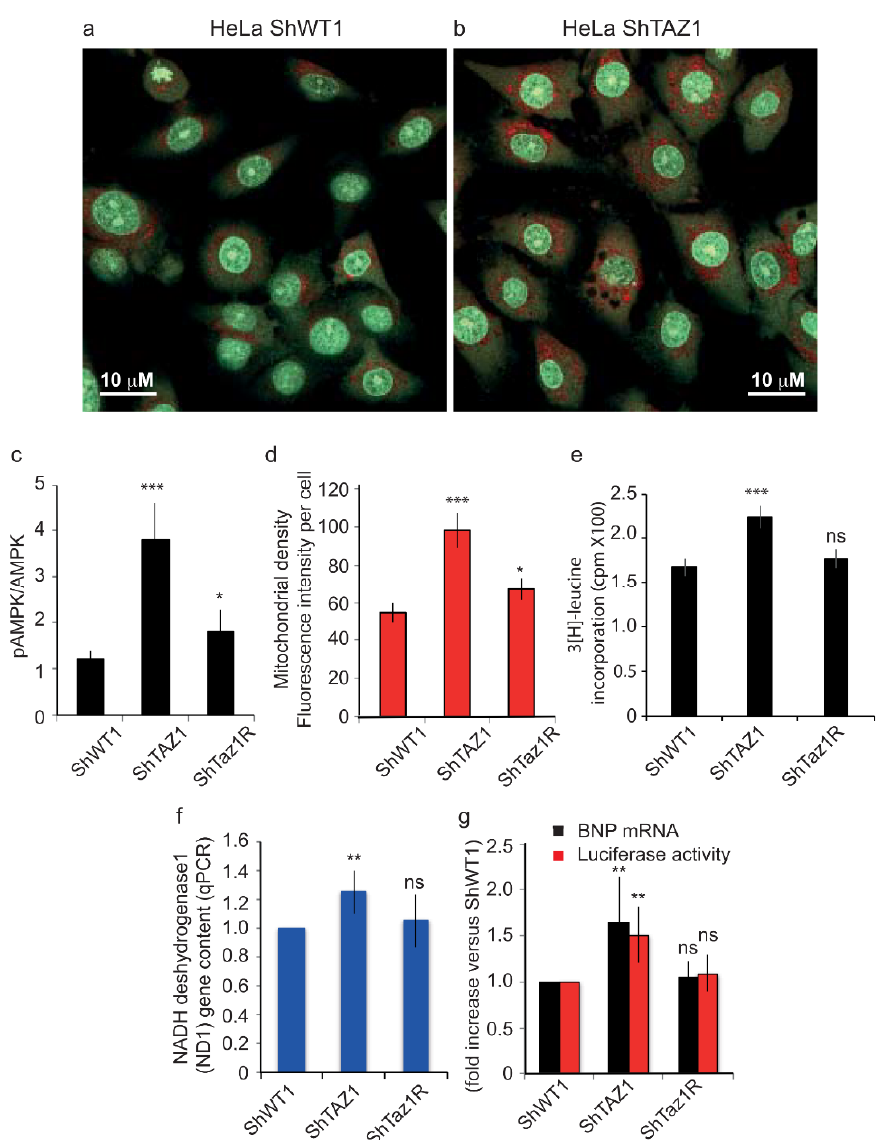
Figure 6. Tafazzin knockdown induces cellular hypertrophy and mitochondrial biogenesis. ( a ) and ( b ) Confocal images of the ShWT1 and ShTaz1 HeLa cells after staining with 5 µ M AO as described in materials and methods. AO stains the nuclei (binds to DNA) and part of the cytoplasm in green (non-aggregated form) and also the acidic vesicles where it accumulates and because of its stacking is subject to a Stokes shift and is re-emitted in red (i.e., mainly the lysosomes and the autophagic vacuoles when present). * p < 0.05 vs. Control HeLa cells (ShWT1). ( c ) ShTaz1 knockdown cells as well as their revertant ShTAZR1 were treated and assayed for phospho-AMPK (p-AMPK) as described in materials and methods. p-AMPK was corrected for total AMPK and expressed as fold increase vs. ShWT1 control (arbitrarily set at 1). ( d ) Quantification of red fluorescence from TMRM staining on confocal images where the intensity per cell is taken into account. ( e ) ShTaz1 cells exhibited increased